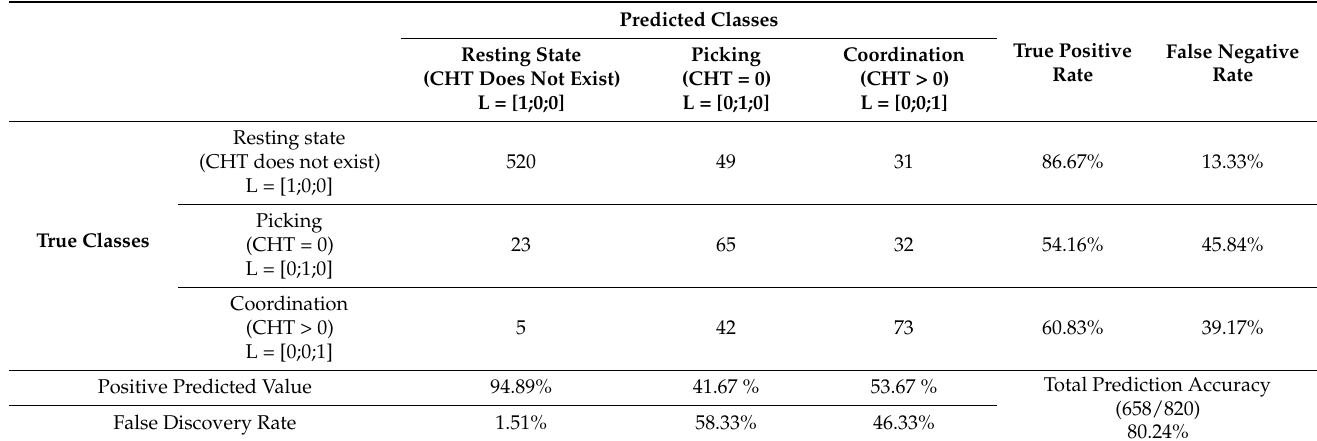
Table A3. Baseline model using single channel (F3)—confusion matrix.